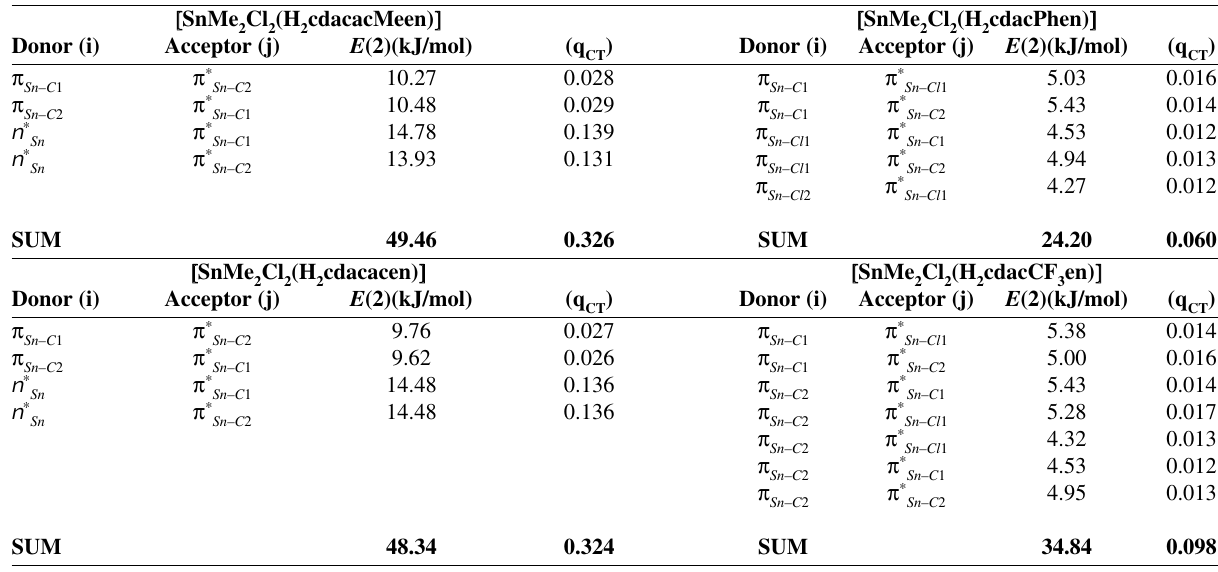
Table 9. Results of second-order perturbation theory analysis of the Fock matrix within the NBO basis for the Sn complexes calculated at B3LYP/LANL2DZ. [[ SnMe Cl (H cdacacMeen) 2 2 2